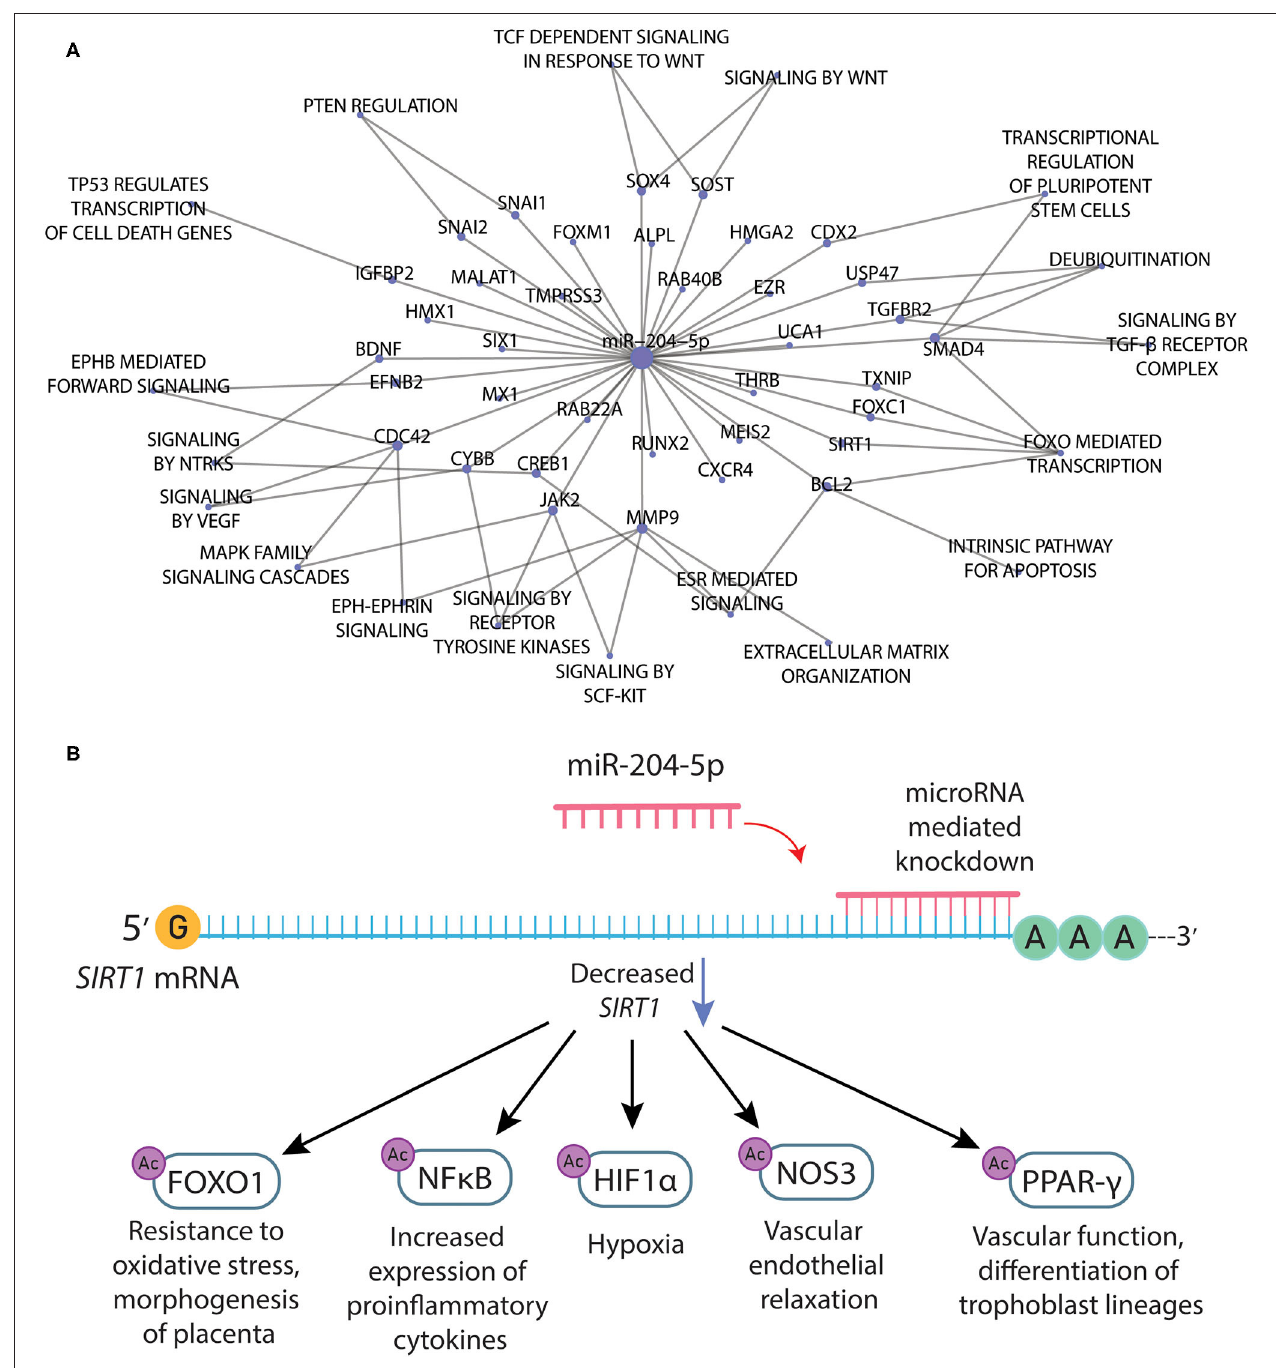
FIGURE 2 | (A) Network connecting the target genes and related pathways for the mir-204-5p according to the selection of experimentally validated miRNA-target interactions from miRTarBase. (B) Downstream targets of SIRT1 that are related to vascular endothelial function or pathways implicated in the pathophysiology of